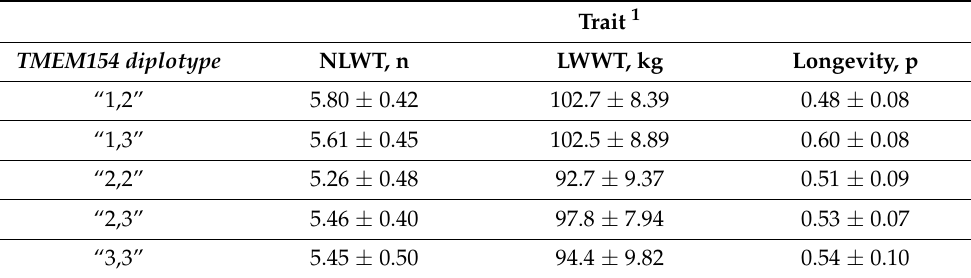
Table 4. Results indicate that each of the five diplotype combinations was similar in lifetime performance and longevity reinforcing the concept that the “2” and the “3” haplotypes are equivalent risk factor alleles. Table 4. Least-square means ( ± SE) for the main effect of TMEM154 diplotype on reproductive performance and longevity through five production years in Experimental flock 2.